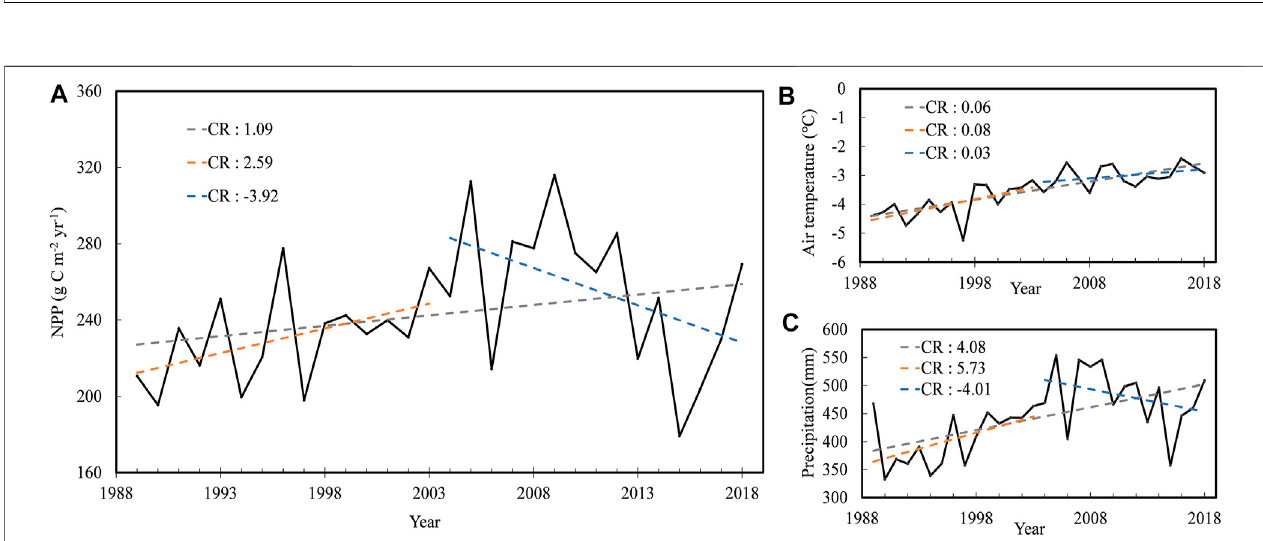
FIGURE 6 | Inter-annual variations of simulated NPP (A) , air temperature (B) and precipitation (C) in the TRHR from 1989 to 2018. Gray, orange and blue dashed